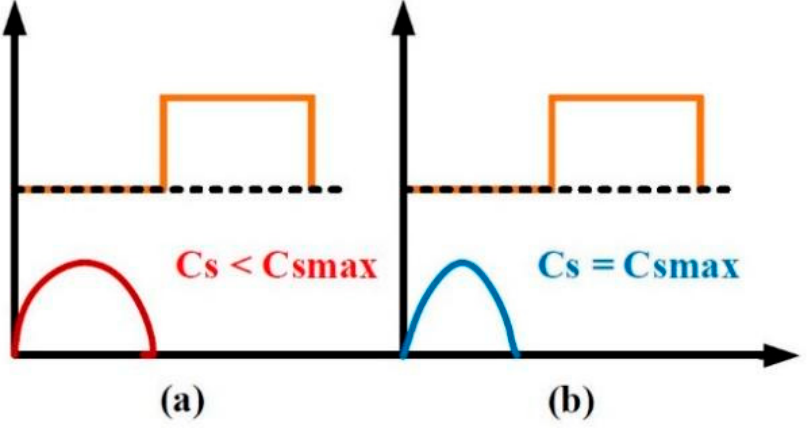
Figure 11. Waveform across the shunt capacitor ( a ) ZVS ( b ) early ZVS.